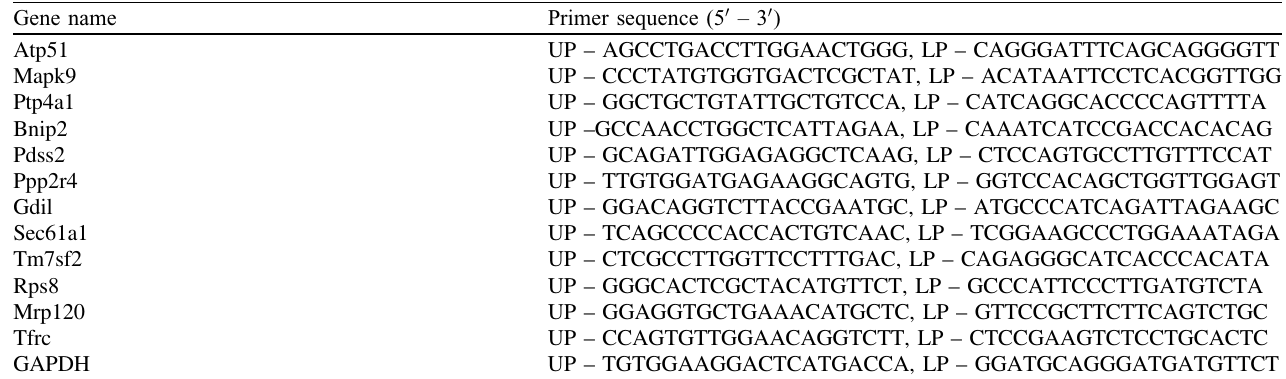
Table 1. Sequence of gene-speci fi c primers for qPCR assays. Gene